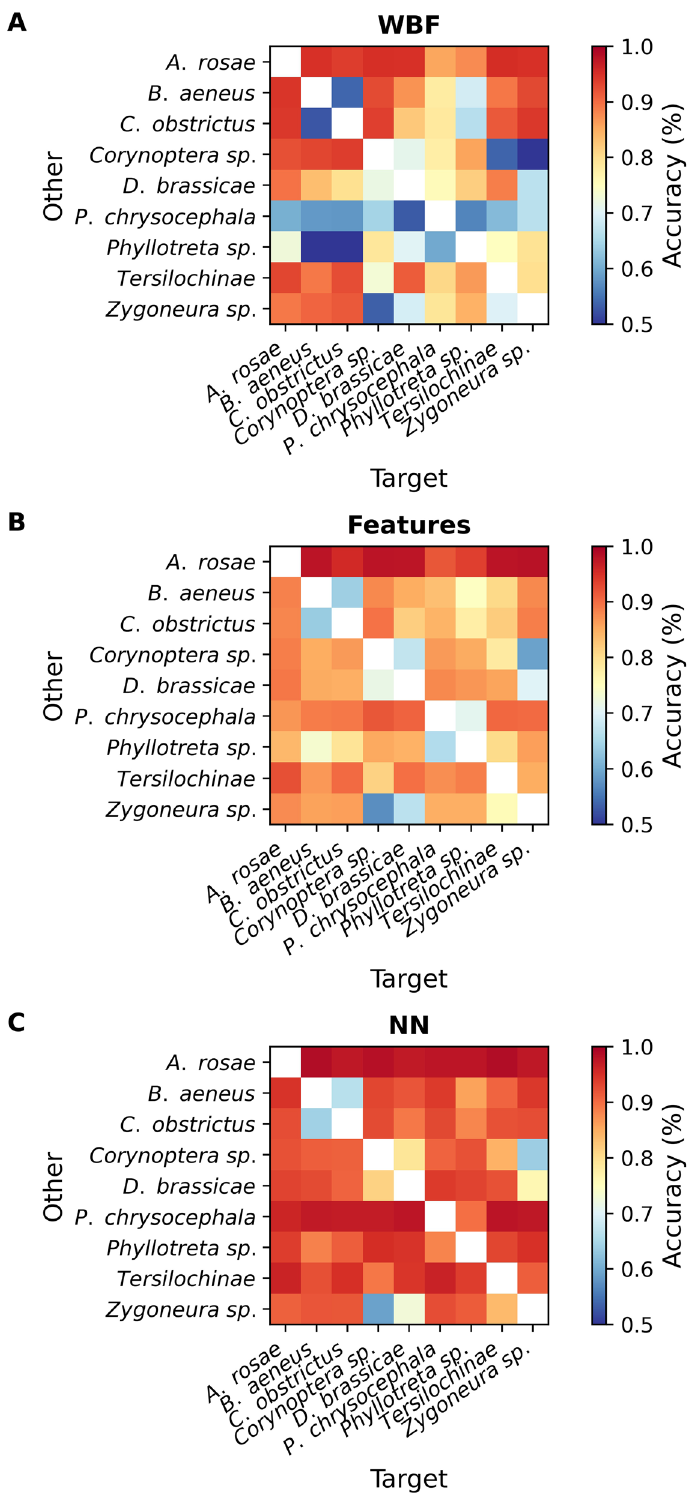
Figure 3. ( A ) Intensity plot of the average accuracy of the classification algorithms using one species as a target and training against a mix of the other species, then testing against specific other species using wing beat frequency as predictor. ( B ) Intensity plot of the average accuracy using one species as target and training against a mix of other species, then testing against specific other species. Here using extracted features as predictors. ( C ) Intensity plot of the average accuracy using one species as target and training against a mix of other species, then testing against specific other species. Here using a neural network (NN) to predict